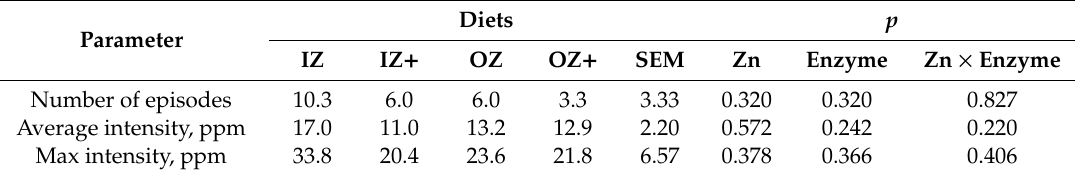
Table 8. The number of episodes, average and maximum intensity (H 2 S detected) of flatus of dogs fed the experimental